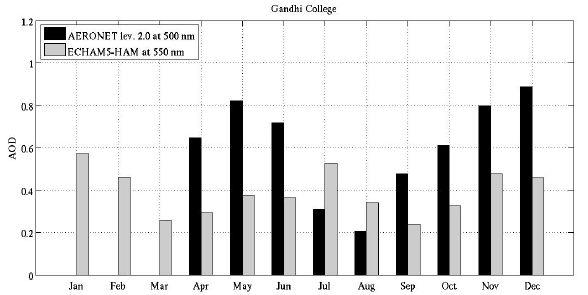
Fig. 15. AOD at Gandhi College from AERONET point measurement in year 2006 at λ = 500nm (black) and as a grid box four-year average from ECHAM5-HAM data using 2006 emissions at λ = 550nm (grey).